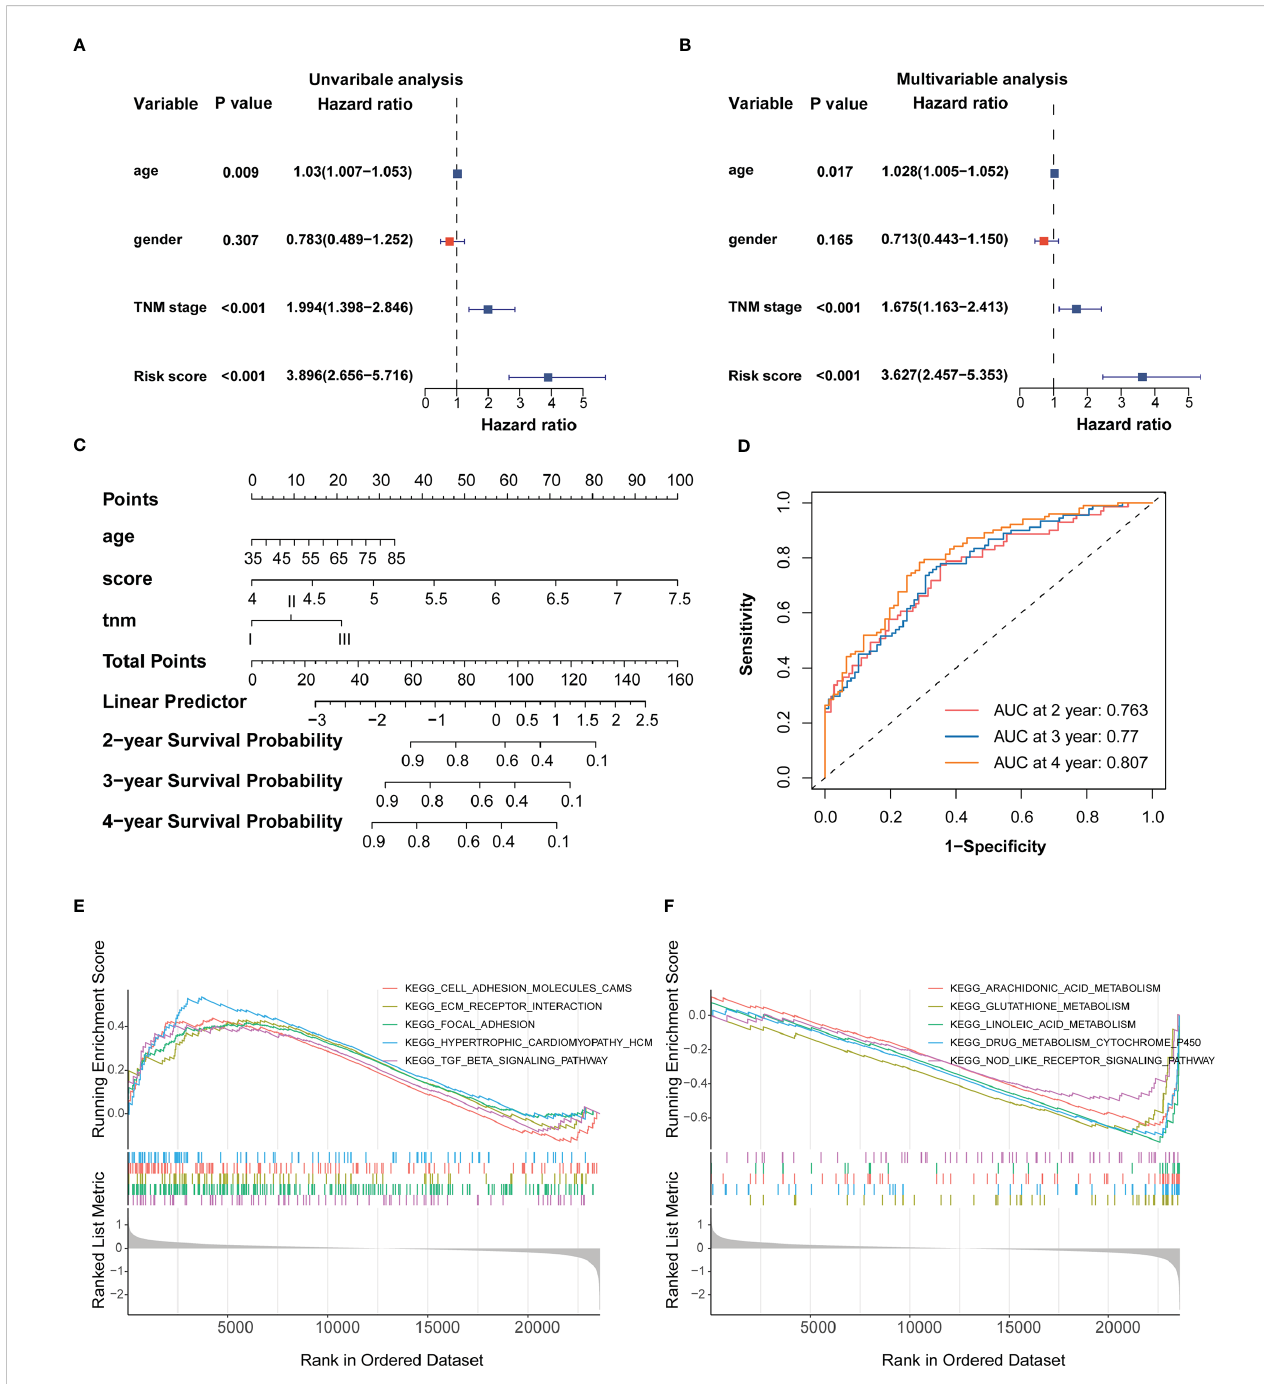
FIGURE 3 Establishment of the IRRS score-based nomogram (A, B) Forest plot of univariable and multivariable Cox regression analysis of IRRS and overall survival in the training cohort. (C) Nomogram to predict the probability of OS in 2, 3 and 4 years for ESCC. (D) AUC values of ROC predicted 2, 3 and 4 year OS rates of Nomogram. (E) GSEA analysis of the high IRRS score group. (F) GSEA analysis of the low IRRS score